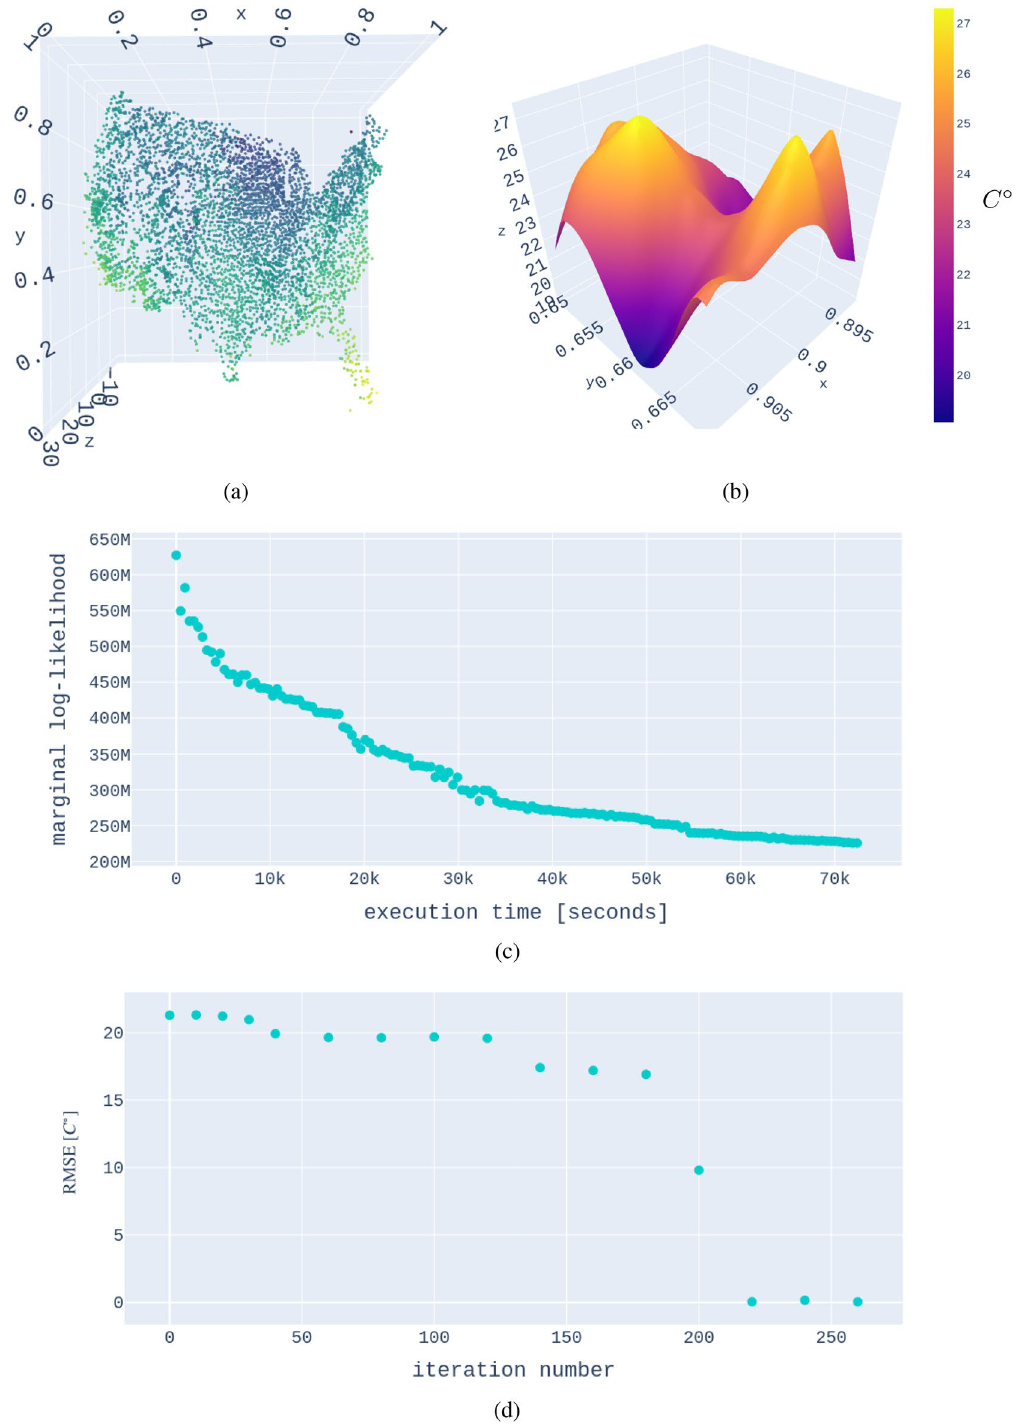
Figure 7. The result of a Gaussian process trained on over 5 million data points. While this paper is best understood as a proof-of-concept, we want to ensure that we show the readers that the resulting model is reasonable by the end of our training ( a , b ). (Panel a ) The distributions of the climate stations with temperatures from the first day of the dataset (Jan 1st, 1990); the axes are normalized. (Panel b ) The GP interpolation over a subdomain in the northeast at a time slice in June 2004. The noise of the measurement was estimated ad-hoc, which explains the somewhat rough appearance of the posterior-mean function. We trained the GP via MCMC for 160 iterations. While this does not reach convergence, it is enough to demonstrate the feasibility of such an extreme-scale GP. Panel ( c ) shows the marginal log-likelihood as a function of training time. The GP was trained in under 24 h, on 256 GPUs, opening the doors for much larger GPs. To verify error convergence, we also extracted a smaller dataset of 103315 points from the full climate dataset. The RMSE with respect to 1000 test points as a function of MCMC iteration number is visualized in panel ( d